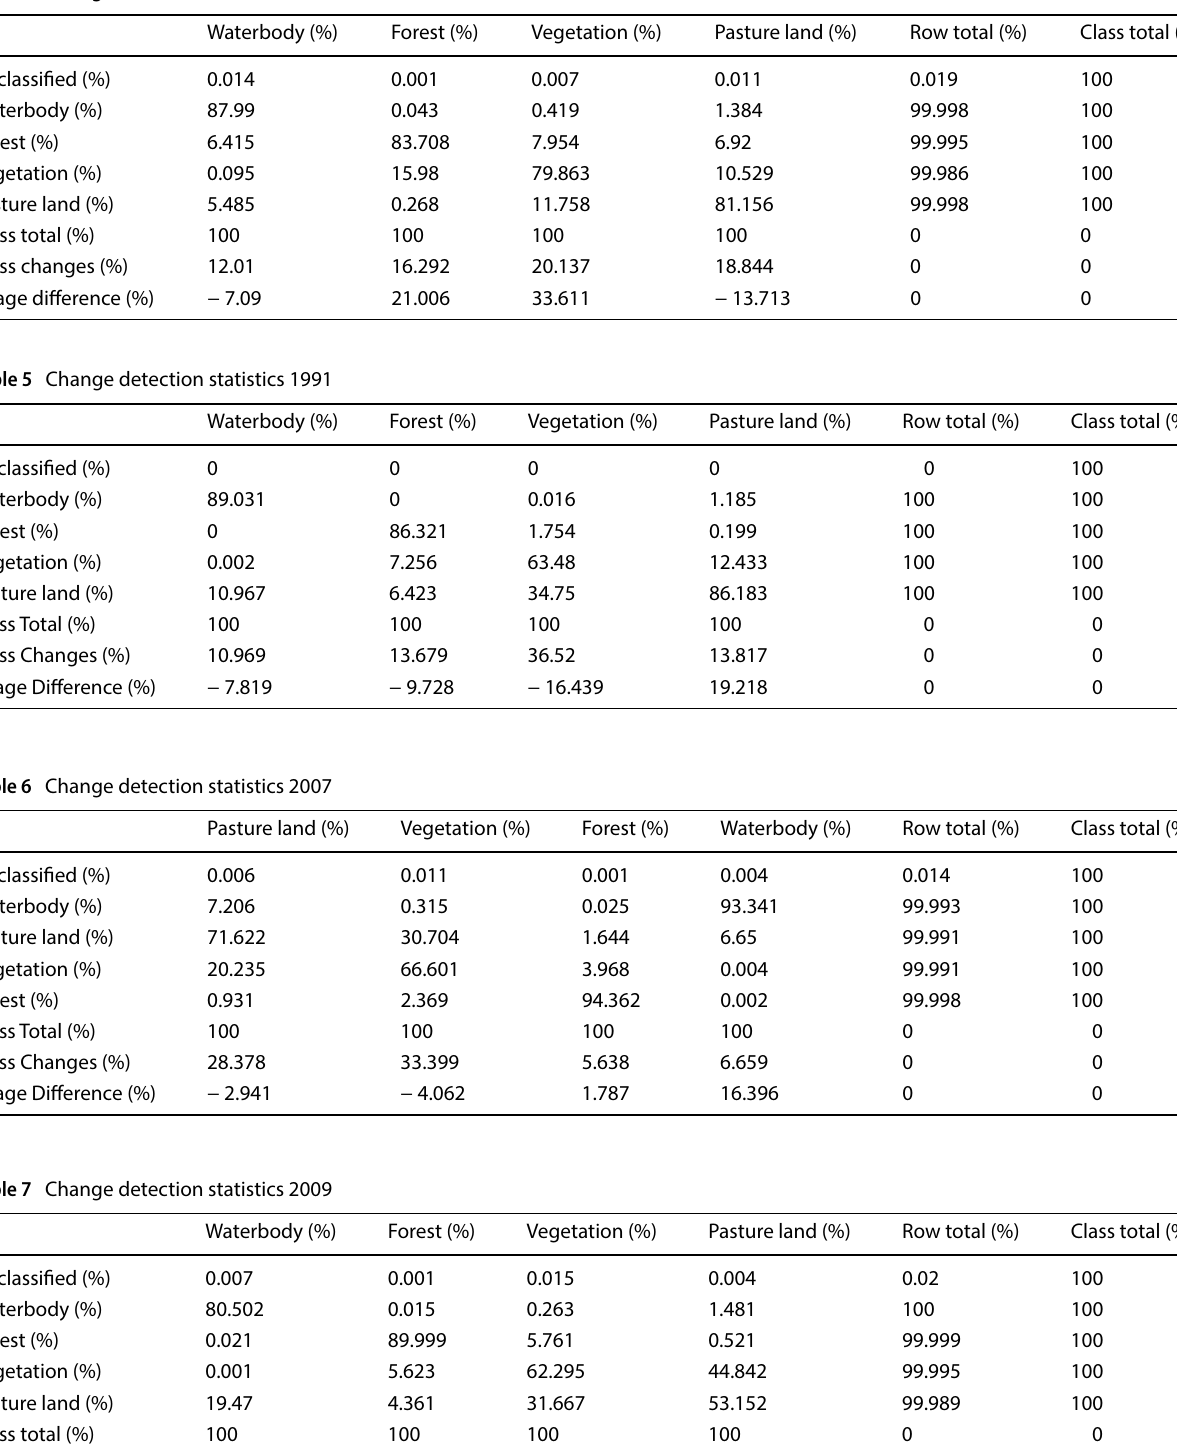
Table 4 Change detection statistics 1988